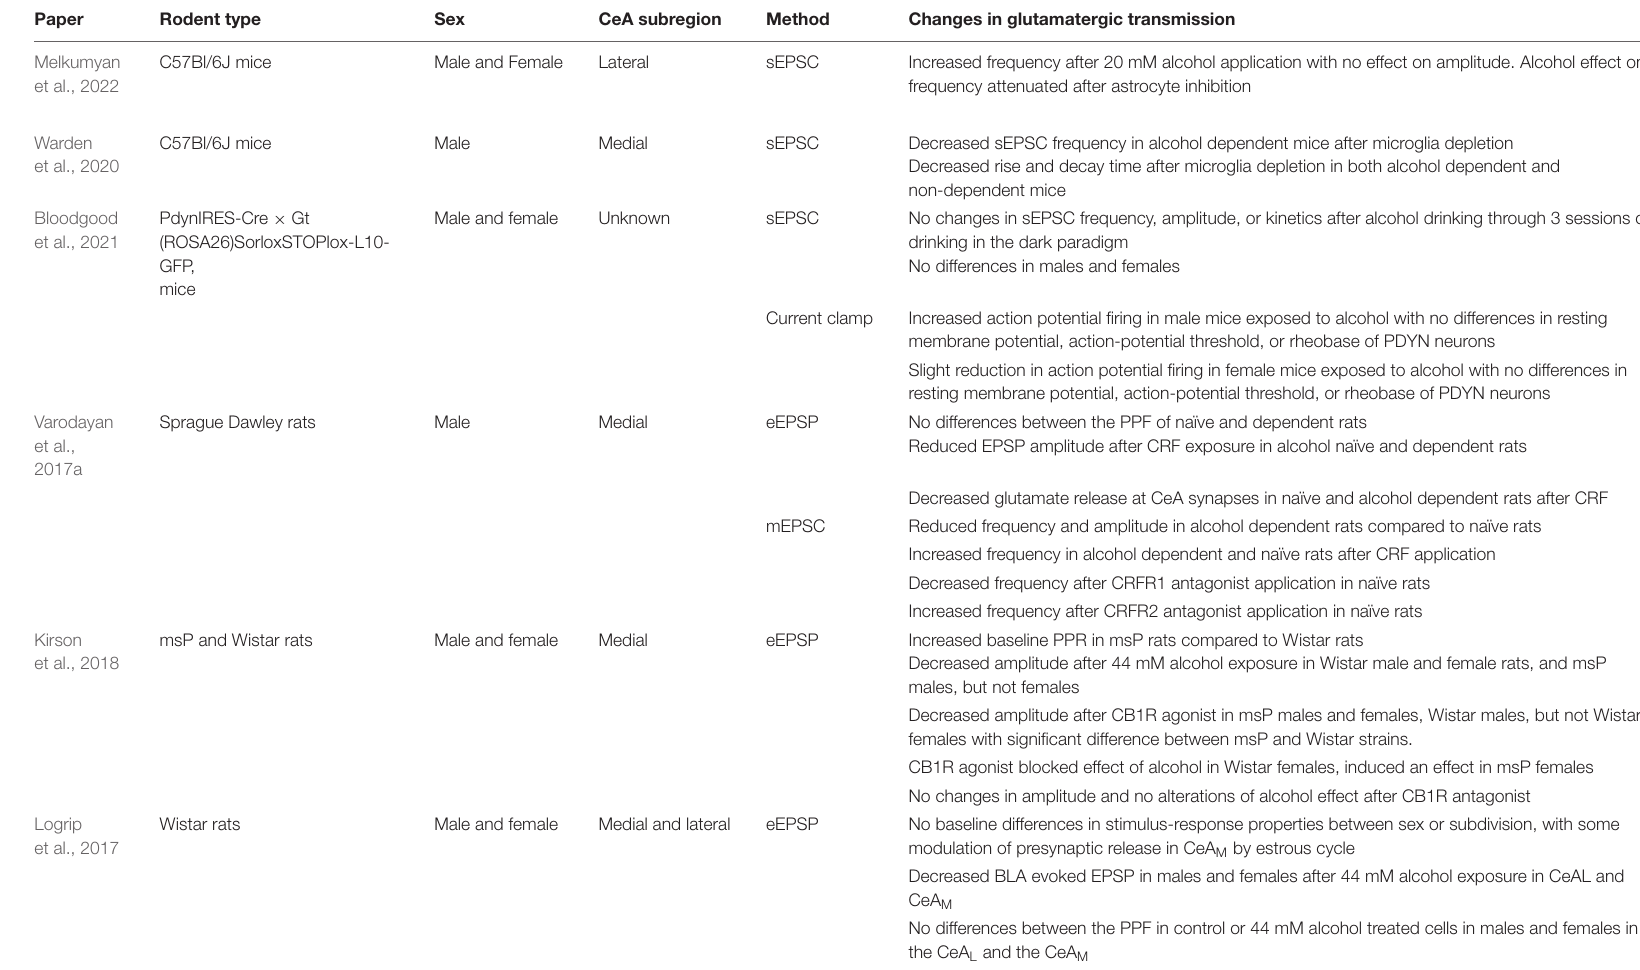
TABLE 2 | Summary of the data from multiple papers looking at glutamatergic transmission in rats and mice through evoked (eEPSC), spontaneous (sEPSC), and mini (mEPSC) inhibitory postsynaptic currents (EPSC).